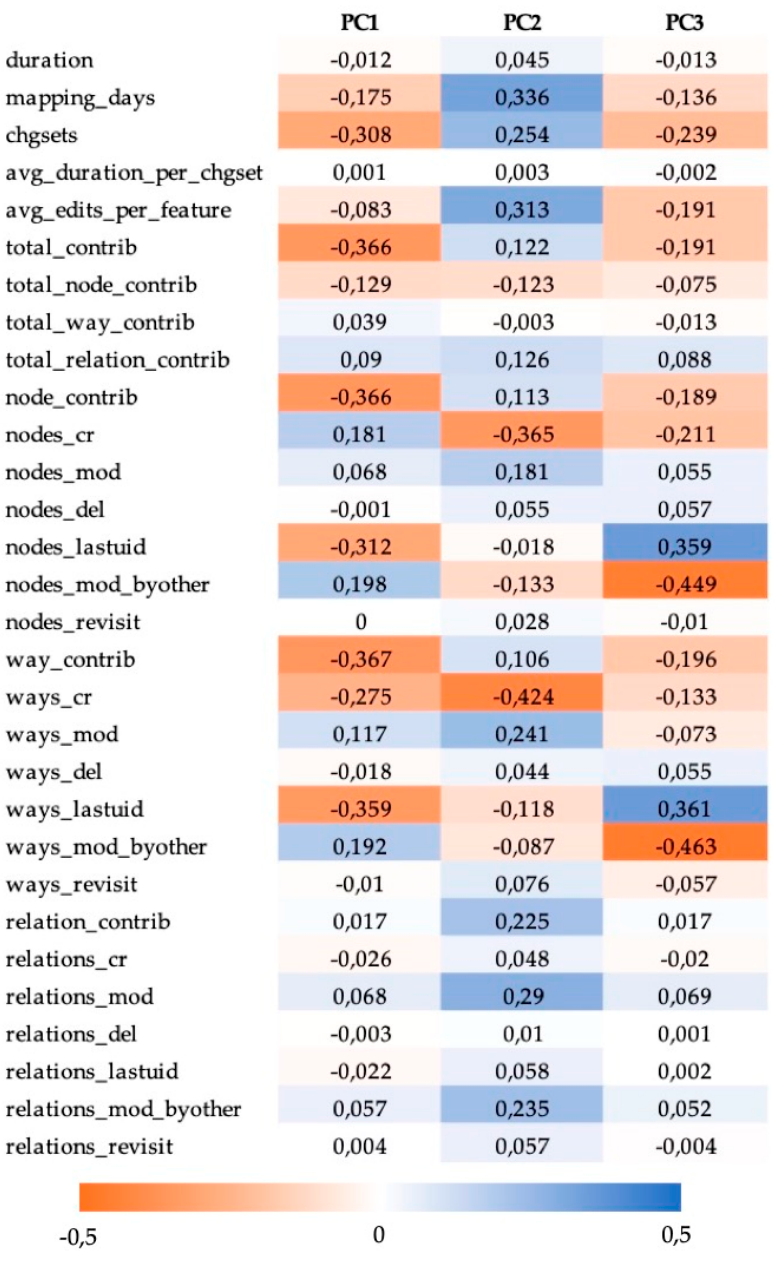
Figure 4. Attribute contribution loadings for each of the three principal components. Table 5. Characterising the principal components.